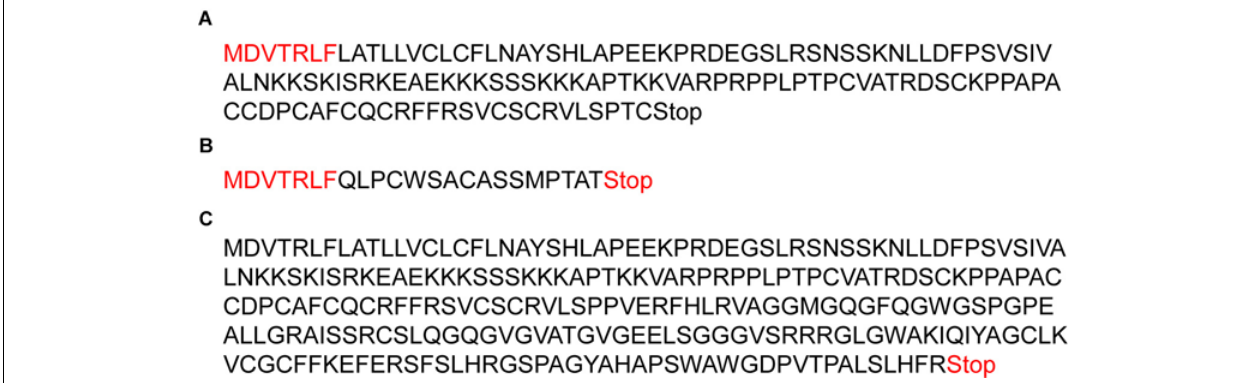
FIGURE 3 | The effect of frameshift mutations on ASIP polypeptide. (A) Normal ASIP polypeptide with 133 amino acids and stop at codon 134; (B) Truncated ASIP protein with 24 amino acids and stop at codon 25 due to frameshift mutation in exon 2; (C) Abnormally long polypeptide with 253 amino acids due to a frameshift mutation in exon 4. Amino acids in red font in (A,B) are before frameshift and, thus shared between the normal and truncated ASIP.